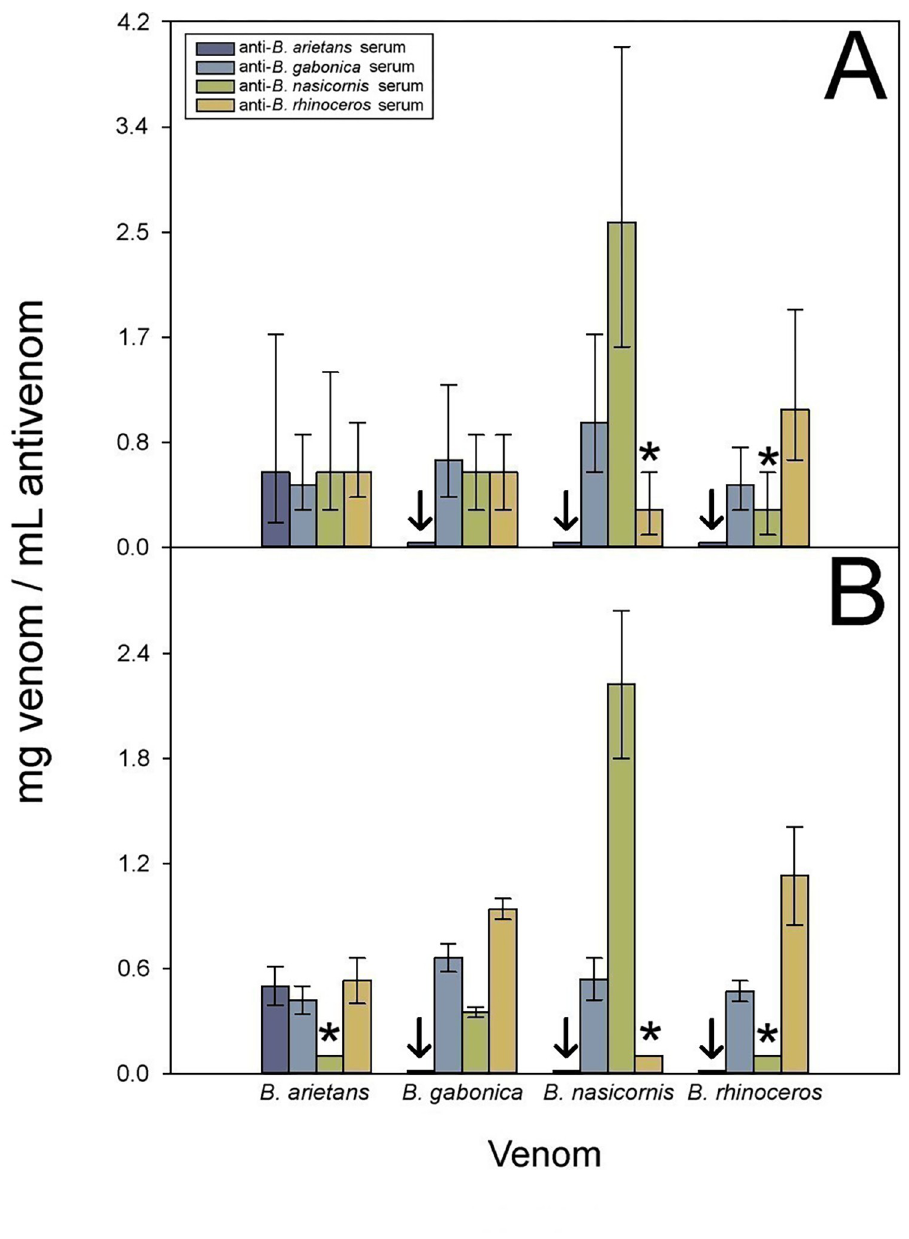
Fig 5. Cross-neutralization of toxic activities of Bitis spp. venoms by monospecific antisera. Cross-neutralization of A) lethal and B) hemorrhagic activities of Bitis spp. venoms. Only the antisera that gave higher than 33% cross- reactivity by ELISA were tested in these assays. Neutralization is expressed as ED 50 , i.e., mg venom neutralized per mL antivenom. In the case of lethality, error bars represent the 95% confidence intervals, while in the case of hemorrhage, error bars represent SD (n = 4). � Non-overlapping values with the anti-lethal 95% CI of the homologous serum, or no detectable ability to neutralize the hemorrhagic activity. # heterologous sera that were no tested as they have less than 33% content of specific antibodies of the corresponding homologous